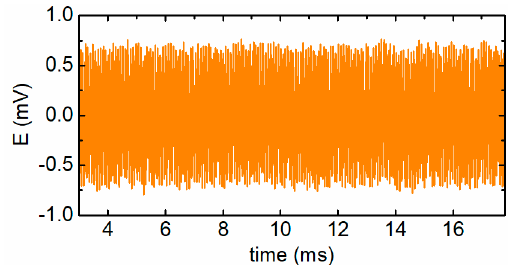
Figure 10. The raw signal of the proposed sensor.